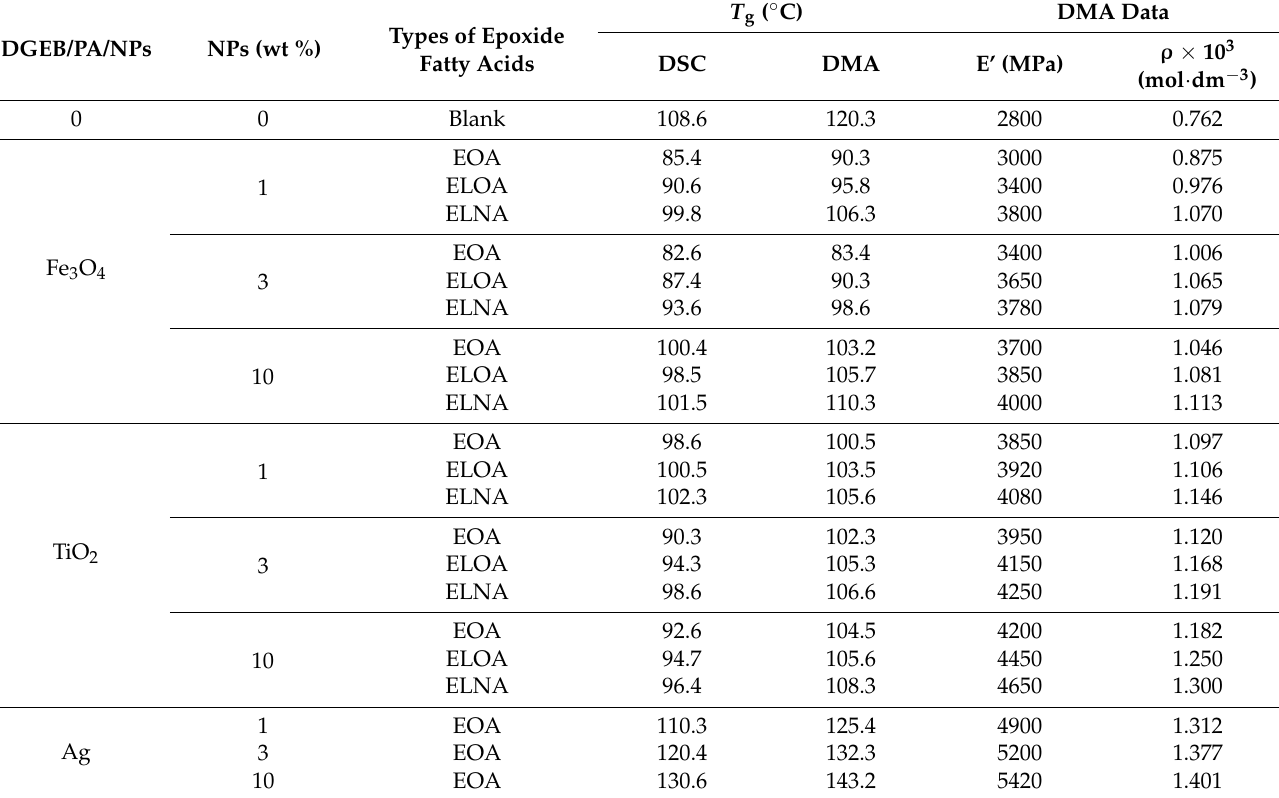
Table 2. DSC and dynamic mechanical analyzer (DMA) data of DGEB/ PA in the presence and absence of different wt % of modified